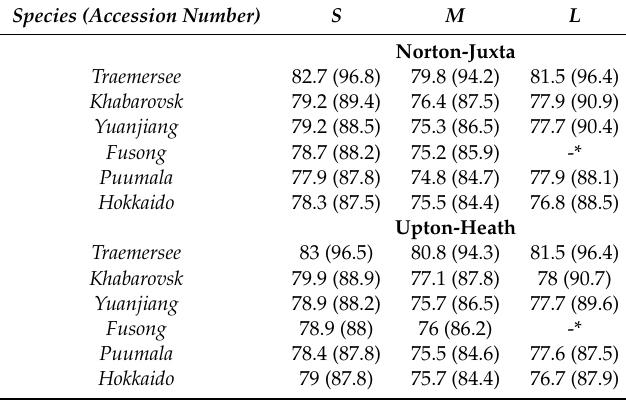
Figure 1. Phylogenetic relationship of Tatenale virus with other vole-associated orthohantavirus species. Representative complete coding sequences were retrieved for each segment; L ( A ), M ( B ) and S ( C ). Maximum likelihood trees were created with a GTR + G + I model, using MEGAX software. Branch lengths were drawn to a scale of nucleotide substitutions per site. L and S trees were based on full-length sequences, whilst the M segment tree was based on the available sequence for the partial Upton-Heath strain. Numbers above individual branches show bootstrap support after 1000 replicates. Tatenale virus strains are highlighted with a blue box. Black triangles represent a compressed species-specific subtree. Sequences are shown with the species name, strain name and the GenBank accession number. PUUV, Puumala virus; HOKV, Hokkaido virus; FUSV, Fusong virus; YUJV, Yuanjiang virus; KHAV, Khabarovsk virus; TOPV, Topografov virus; TATV, Tatenale virus; TRAV, Traemmersee virus; PHV, Prospect Hill virus; ILV, Isla Vista virus; TULV, Tula virus; ADLV, Adler virus; LUXV, Luxi virus; FUGV, Fugong virus; ANDV, Andes virus. Table 1. The similarity of Norton-Juxta and Upton-Heath strains of Tatenale virus to the closest related strain of the most related species at nucleotide (amino acid) level. Similarities to the M segment of the Upton-Heath strain are based on the available partial sequence. * Indicates no complete sequence data available.